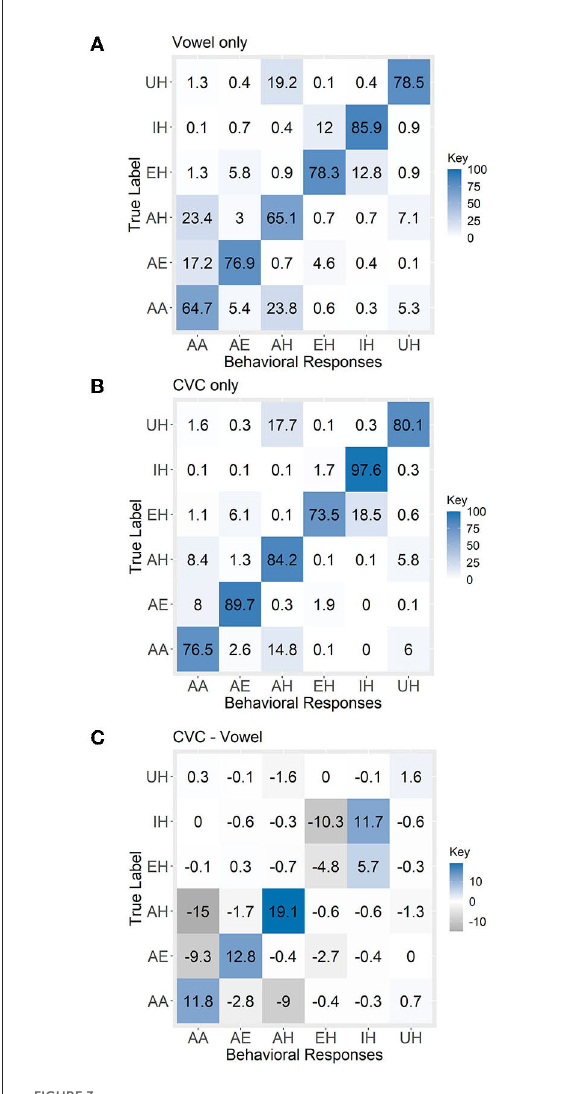
FIGURE3 Confusion matrix for (A) vowel-only condition, (B) CVC condition and (C) CVC—vowel only. Each cell of the confusion matrix was divided by the number of trials per vowel (e.g., 18 trials) and converted to a percentage. Along the diagonal are the percent of trials accurately classified as each vowel when vowel was present (i.e., responded /EH/ on true /EH/ trial). Down the vertical is each category of incorrect behavioral response broken down by true vowel identity (i.e., percent of trials identified as /EH/ which contained a true /IH/, a true /AA/, etc.; showing which vowels participants were incorrectly categorizing by vowel category/rate of Type I false positives/errors of commission). Across the horizontal are inaccurate participant responses from each vowel category broken down according to true vowel identity (i.e., true /EH/ trials incorrectly identified as /IH/, as /AH/, etc.; showing which vowels participants were failing to categorizing as a particular vowel category by incorrect label given, aka rate of Type II false negatives/errors of omission). All vowel labels are in ARPAbet. /EH/ was the only vowel that had a better recognition accuracy, by 4.8%, when presented as an isolated vowel than when it is presented in